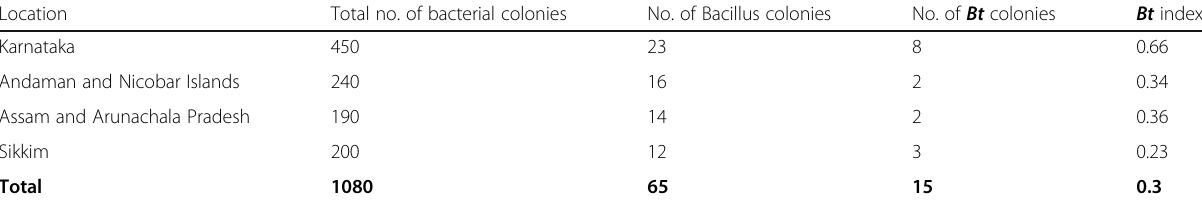
Table 2 Distribution of B. thuringiensis and Bt index based on sample and location Location